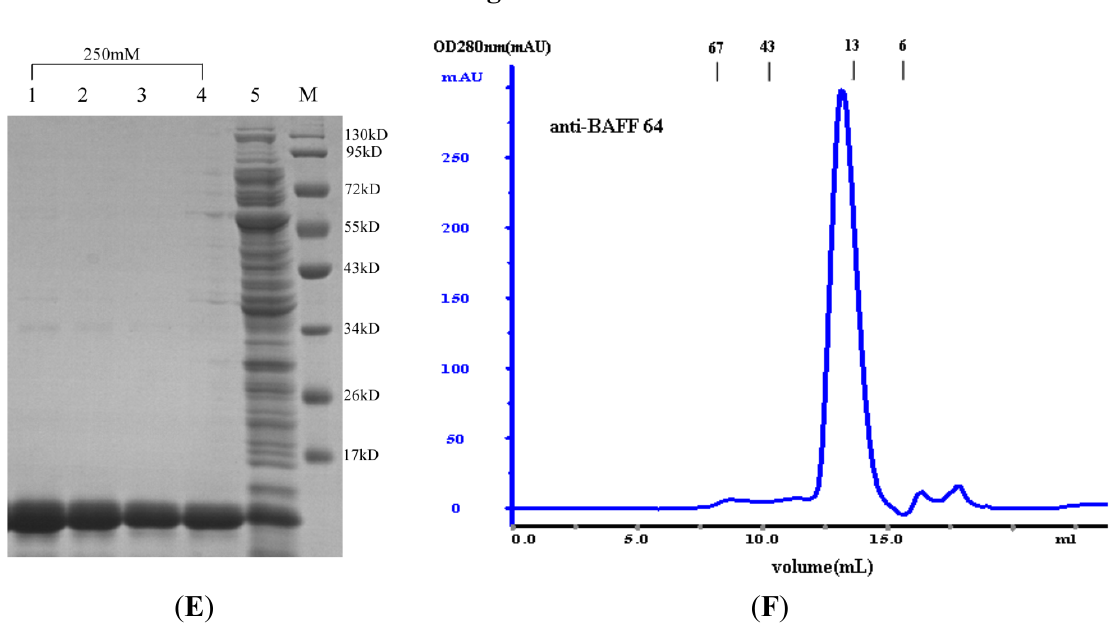
Table 2. The relative affinity of selected antagonistic anti-BAFF (B cell-activating factor) sdAbs as measured by BioLayer interferometry (BLI) using Forte Bio’s Octet System.